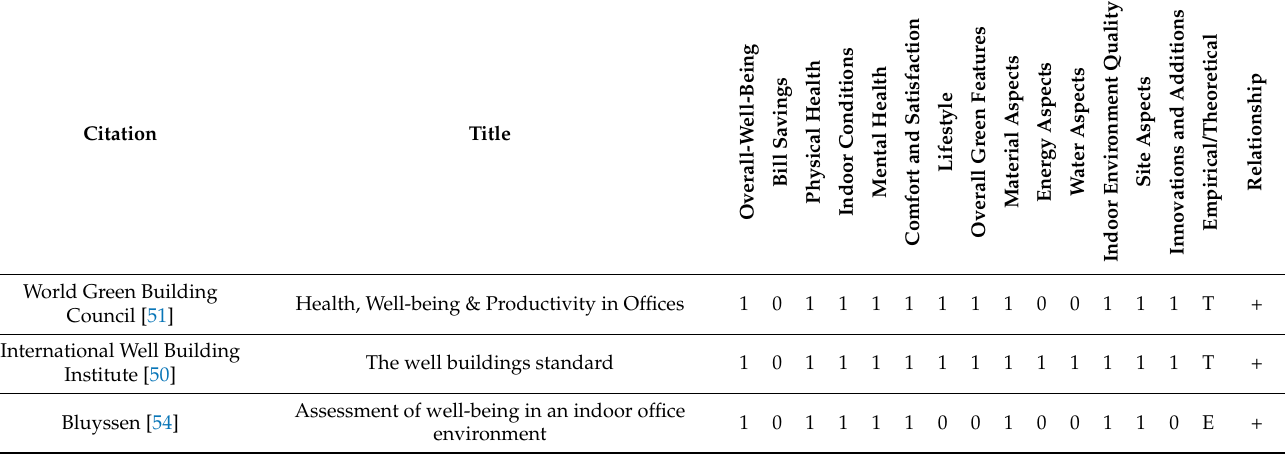
Table A1. The influences of green building on different dimensions of occupants’